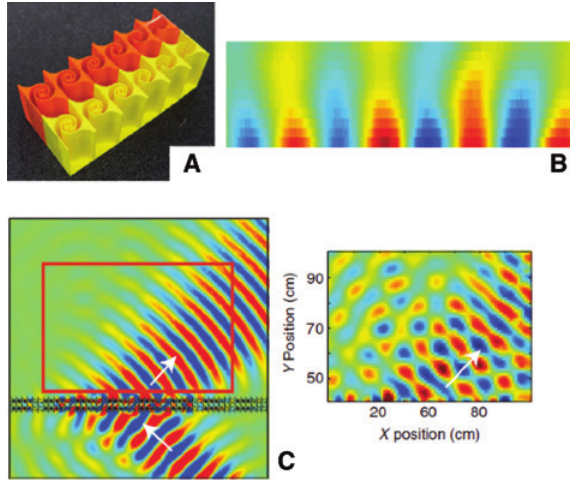
Figure 8: Acoustic metasurface based on taped labyrinthine structure.